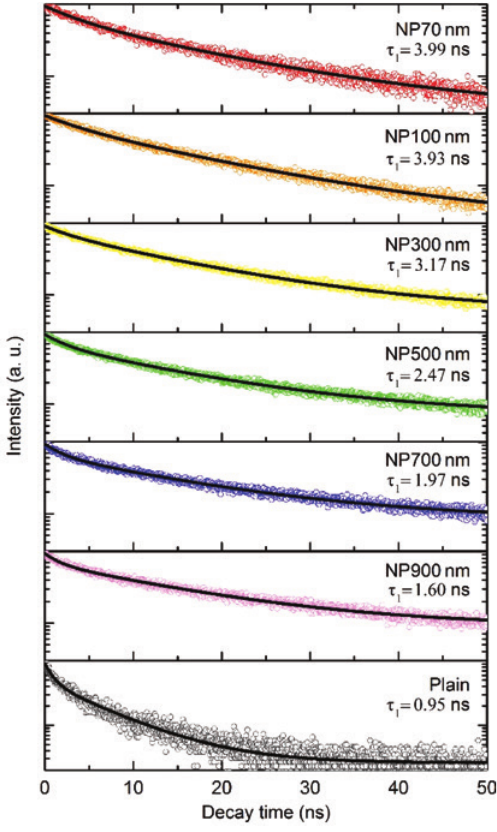
Figure 4: TR-PL decay curves for different samples acquired at room temperature.